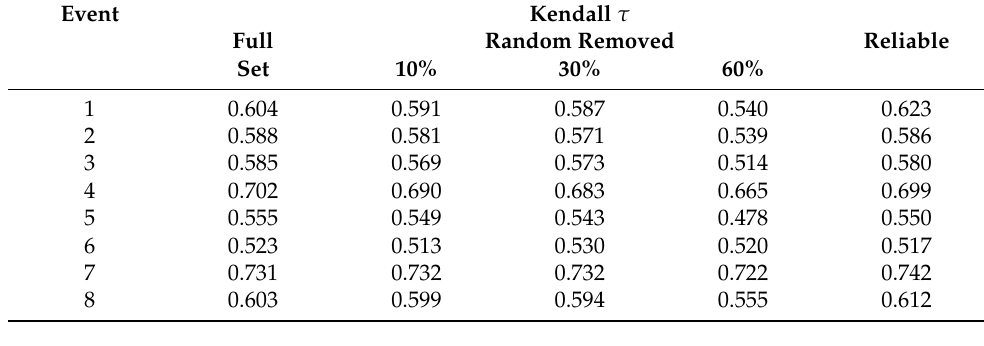
Table 4. Rain event correlations—Netherlands: Full set of CML, percent of randomly selected CML removed, and Reliable only (outliers removed).